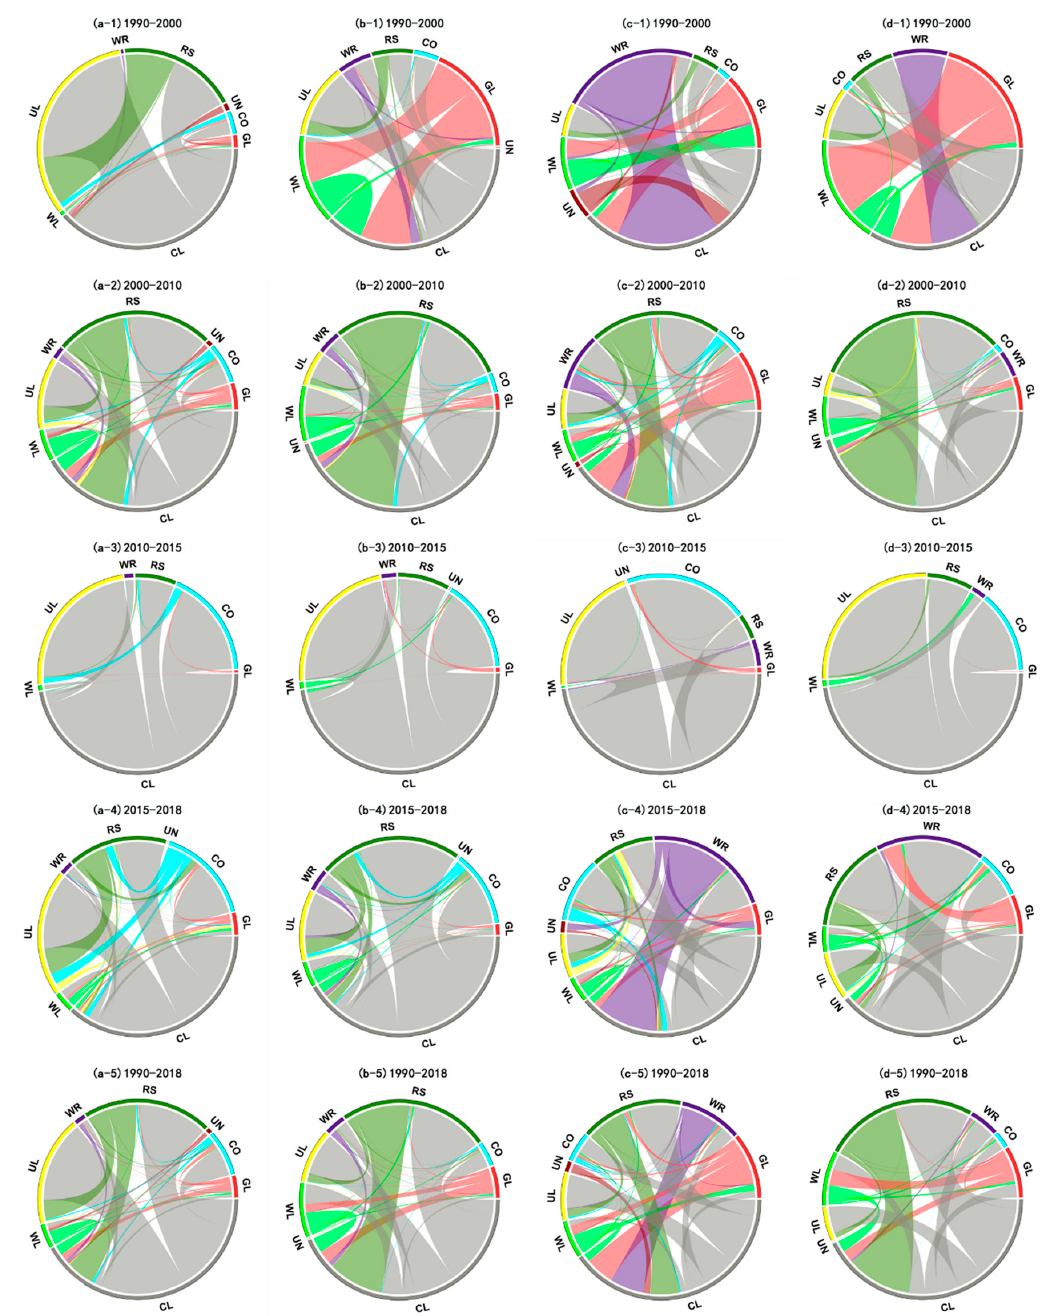
Figure 3. Chord diagrams of quantitative changes in land use/cover (LUCC) change in the four basins, from 1990 to 2018. ( a-1 ), ( a-2 ), ( a-3 ), ( a-4 ), and ( a-5 ) show quantitative changes in LUCC in the HRB. ( b-1 ), ( b-2 ), ( b-3 ), ( b-4 ), and ( b-5 ) show quantitative changes of LUCC in the HURB. ( c-1 ), ( c-2 ), ( c-3 ), ( c-4 ), and ( c-5 ) show quantitative changes of LUCC in the YERB. ( d-1 ), ( d-2 ), ( d-3 ), ( d-4 ), and ( d-5 ) show quantitative changes of LUCC in the YARB. WL, GL, WR, UN, CL, UL, RS, and CO denote the woodland, grassland, water, unused land, cultivated land, urban land, rural settlement, and other construction land, respectively.